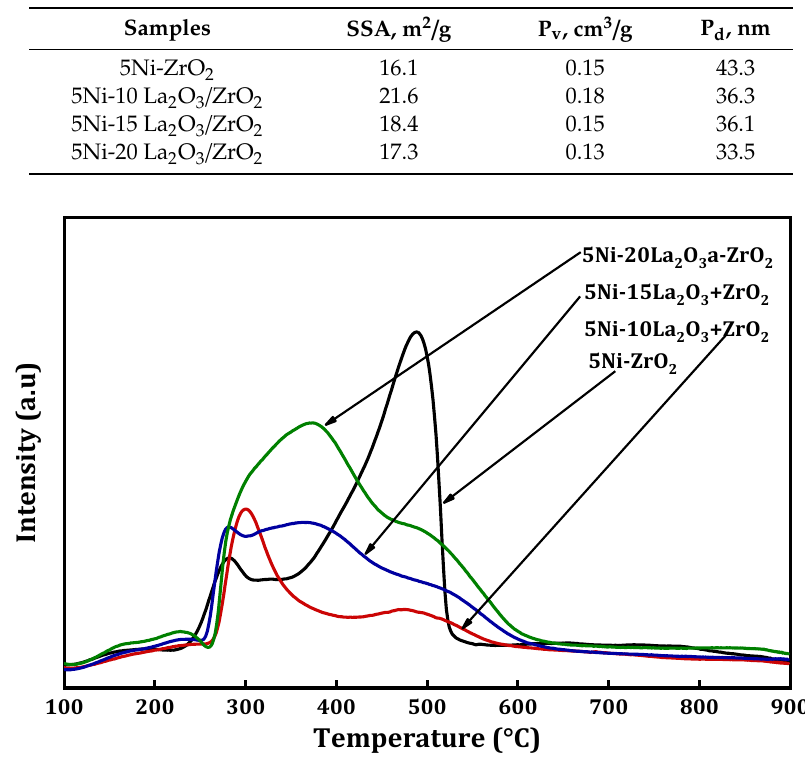
Figure 2. H 2 -temperature programmed reduction (TPR) profiles of 5Ni-ZrO 2 and La 2 O 3 -promoted 5Ni-ZrO 2